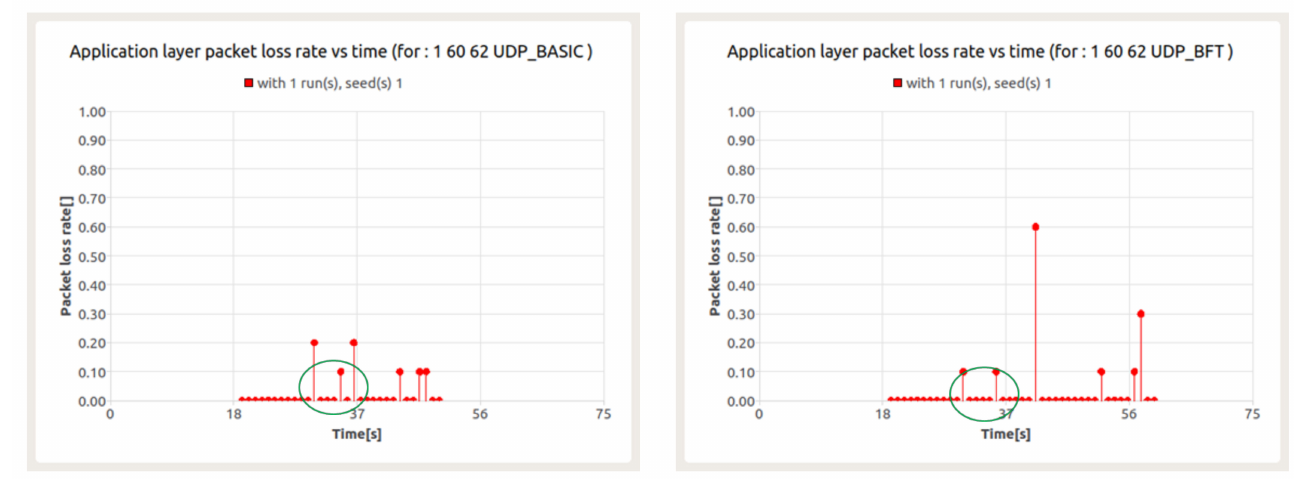
Figure 19. Packet loss ratio for UDP ( left ) and BFT ( right ) sessions in the presence of background traffic—node